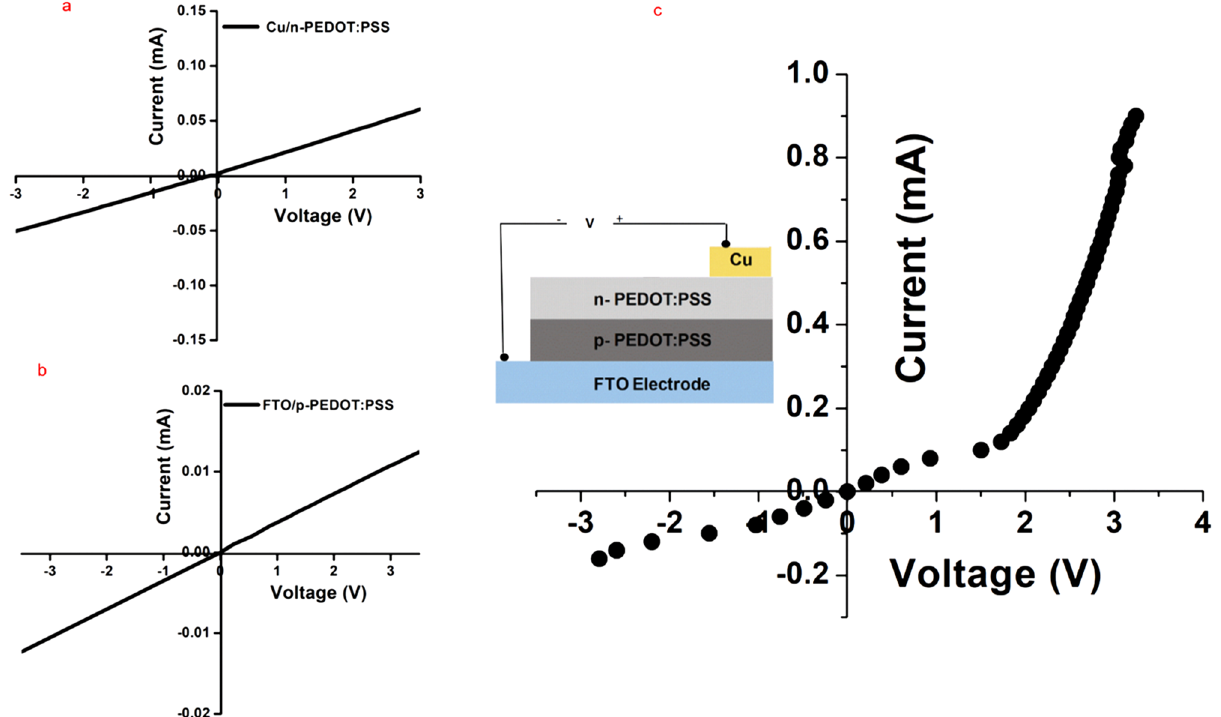
Figure 5. ( a ). I–V curve of ( a ) Cu electrode and n-PEDOT:PSS and ( b ) FTO and p-PEDOT:PSS layers. ( c ) I–V curve of FTO/p-PEDOT:PSS/n-PEDOT:PSS/Cu homojunction diode with area of 0.5 cm 2 . The inset is schematic structure of the